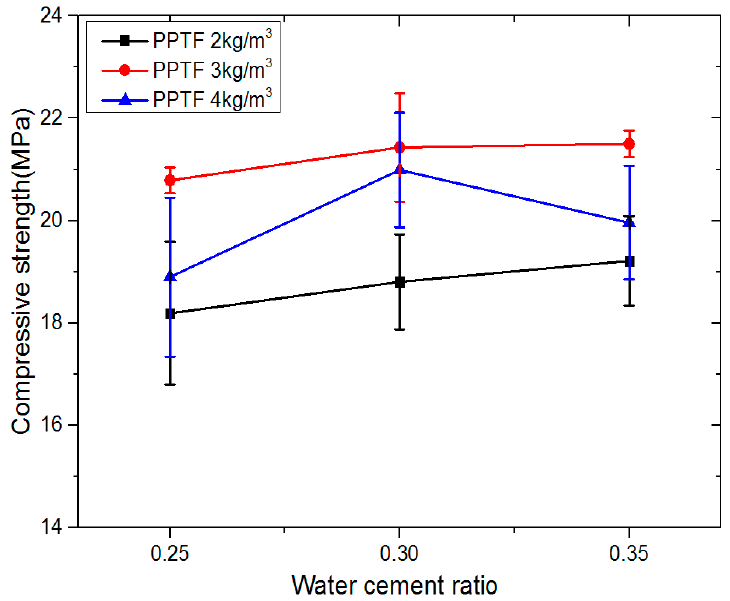
Figure 7. Influence of water-cement ratio on compressive strength.